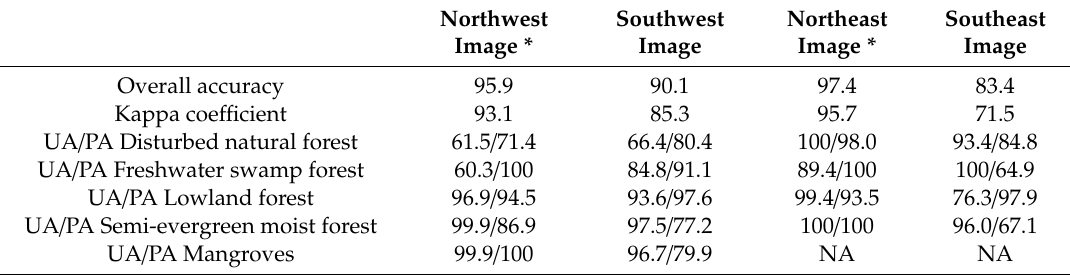
Table 2. The accuracy of forest type classification based on the combination of Sentinel-2 bands at 10 and 20 m spatial resolution and DEM, * images used for parametrisation of the classification models, UA: user’s accuracy, PA: producer’s accuracy.